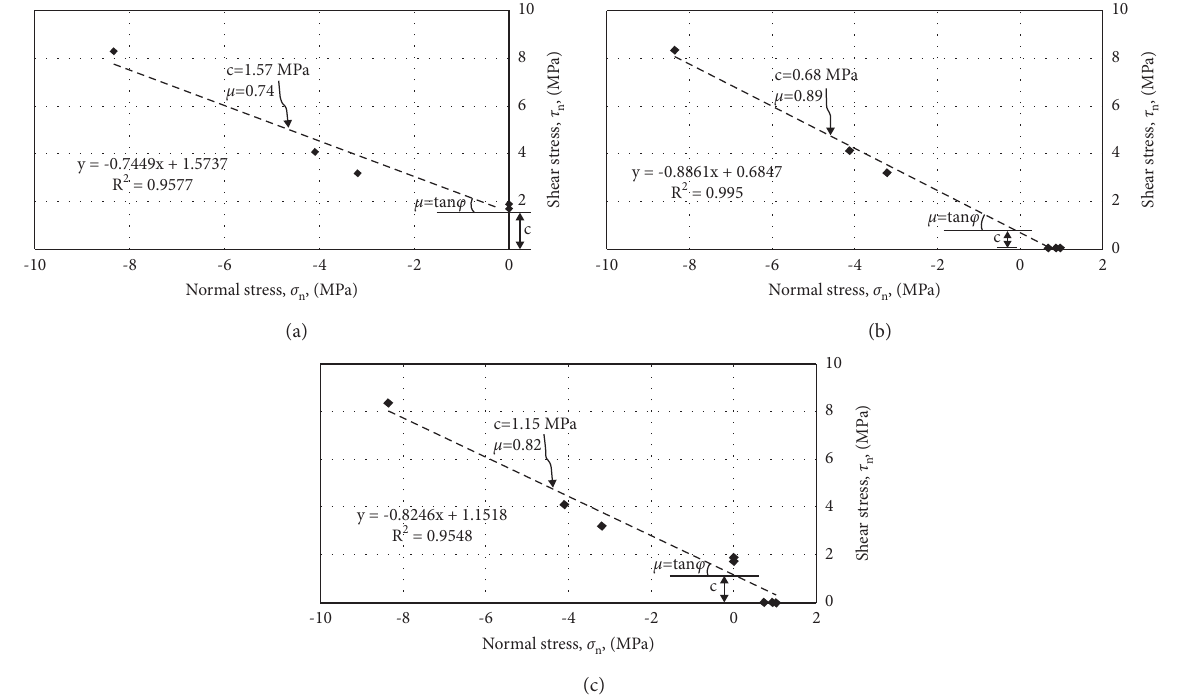
Figure 12: Experimental shear-normal stress interaction and linear extrapolation. (a) Push-off and slant shear. (b) Direct tension and slant shear. (c) Direct tension, push-off, and slant Table 6. The findings show that cohesion value and friction coefficient from the data of push-out and slant shear tests were 1.57 MPa and 0.74, while the values from the data of tension and slant shear test were 0.68 MPa and 0.89, re-